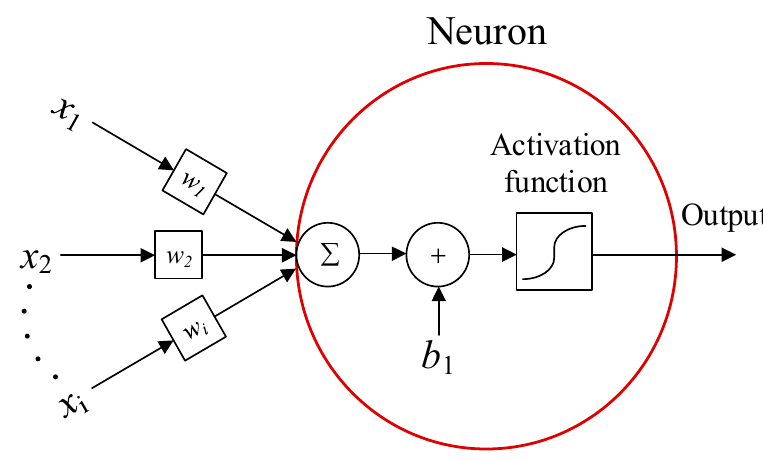
Figure 6. Mathematical function of a neuron in an ANN model.